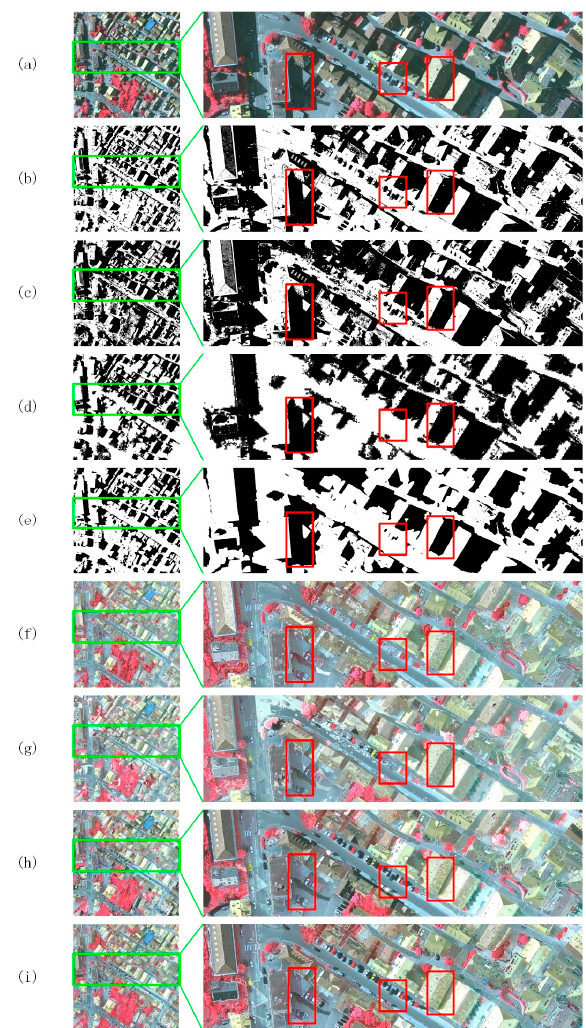
Figure 6. Results of the shadow detection and removal methods in test 2, and zoomed images of the green boxes: ( a ) original imagery; ( b ) result of TSM; ( c ) result of LMM; ( d ) result of the proposed method; ( e ) manually delineated shadow mask; and ( f – i ) shadow compensation results based on the shadow masks in ( b – e ). Remote Sens. 2017 , 9 , 469